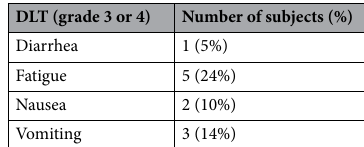
Table 2. Dose limiting toxicities (DLT) in